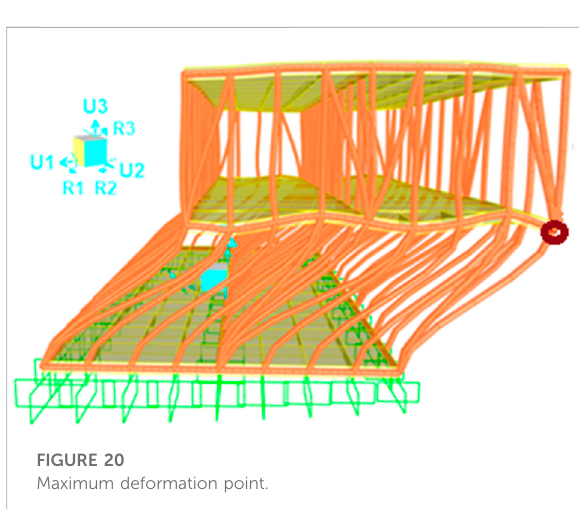
FIGURE 20 Maximum deformation